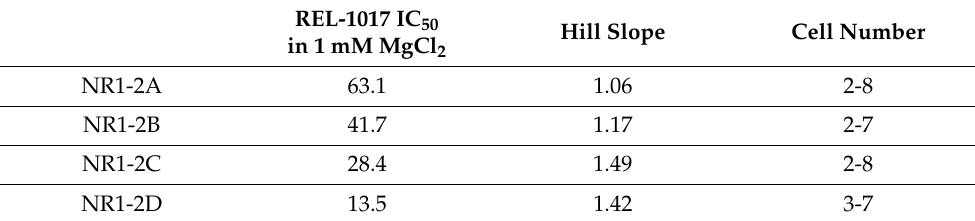
Table 3. IC 50 values of REL-1017 in presence of Mg 2+